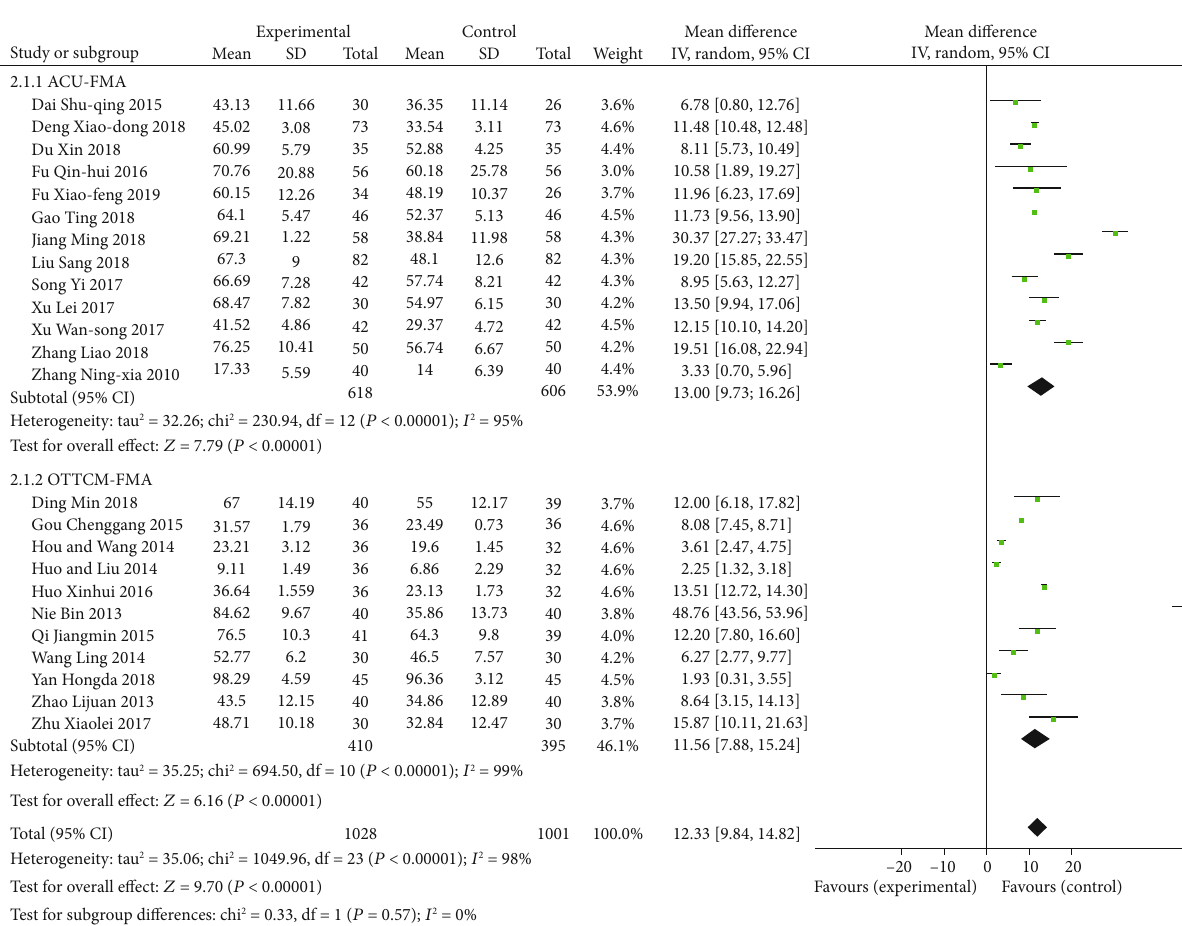
Figure 9: Forest plot of FMA in patients treated with ACU or OTTCM combined with routine treatment. Table 6: TCMs combined with routine treatment vs. routine treatment on hemorheological